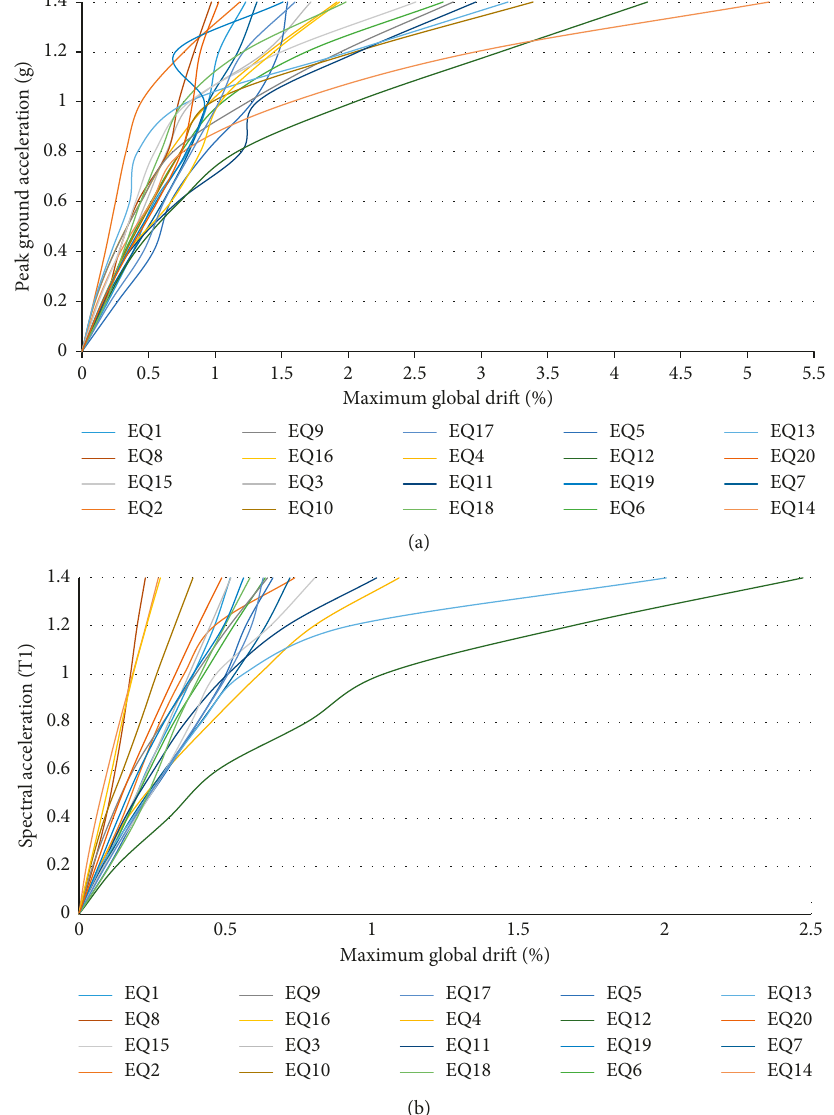
Figure 6: IDA curves: (a) maximum global drift v/s PGA; (b) maximum global drift v/s spectral acceleration scaled at the fundamental time period of the structure ( S a (T1)).